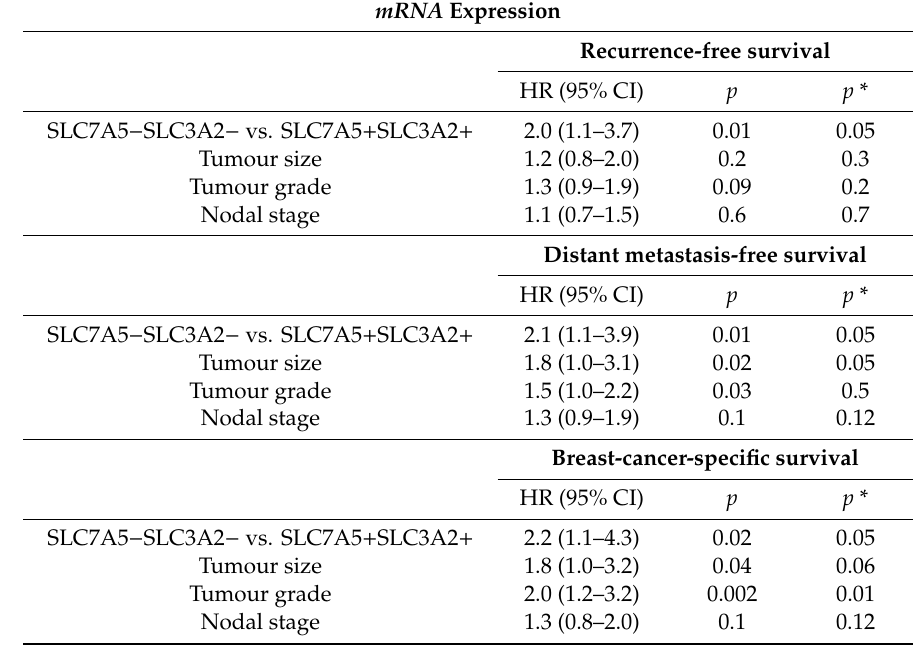
Table 3. Multivariate cox analysis of associations between SLC7A5 / SLC3A2 co-expression and clinicopathological parameters in the ER +/ HER2 −